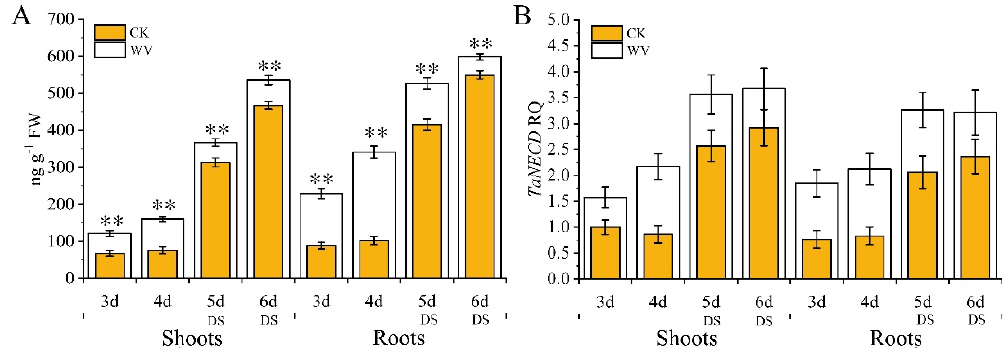
Figure 3. Dynamic changes in abscisic acid (ABA) content and expression pattern analysis of TaNECD of wheat shoots and roots in both the control and WV treated groups before and after the drought stress treatments. The concentration of WV was 0 and 1:900 in control and WV treated groups, respectively. The stages of non-drought stress and drought stress were from day 3 to day 4 and from day 5 to day 6, respectively, in the control and WV treated groups. ( A ) Changes of ABA content; ( B ) expression pattern of TaNECD . Data are means ± SD of three independent experiments (biological